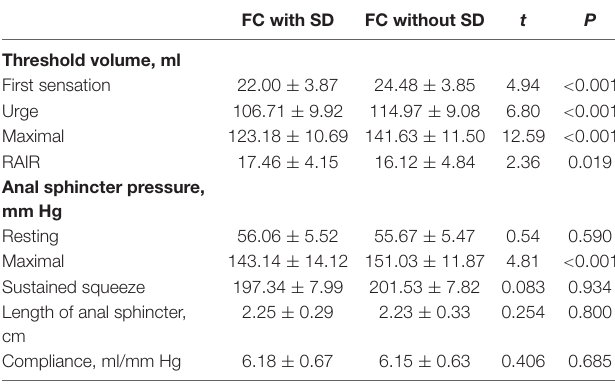
TABLE 3 | Anorectal function in FC patients with or without